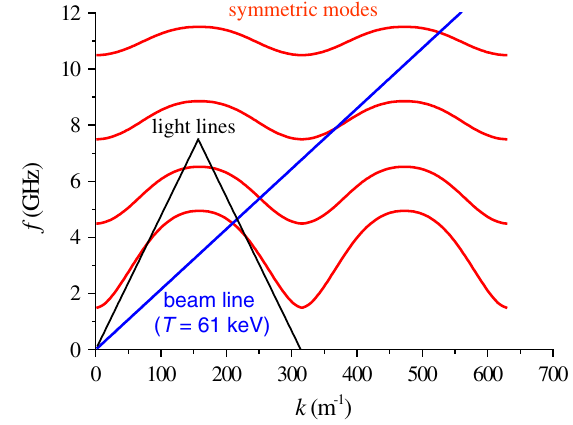
FIG. 13. Dispersion relation for the four lowest symmetric modes of the grating with sidewalls, extended over the first and second Brillouin zones (red). The forward and backward light lines are shown (black), along with a beam line correspond- ing to 61 keV (blue). The intersections with the high frequency modes occur at frequencies which correspond to allowed SP radiation.